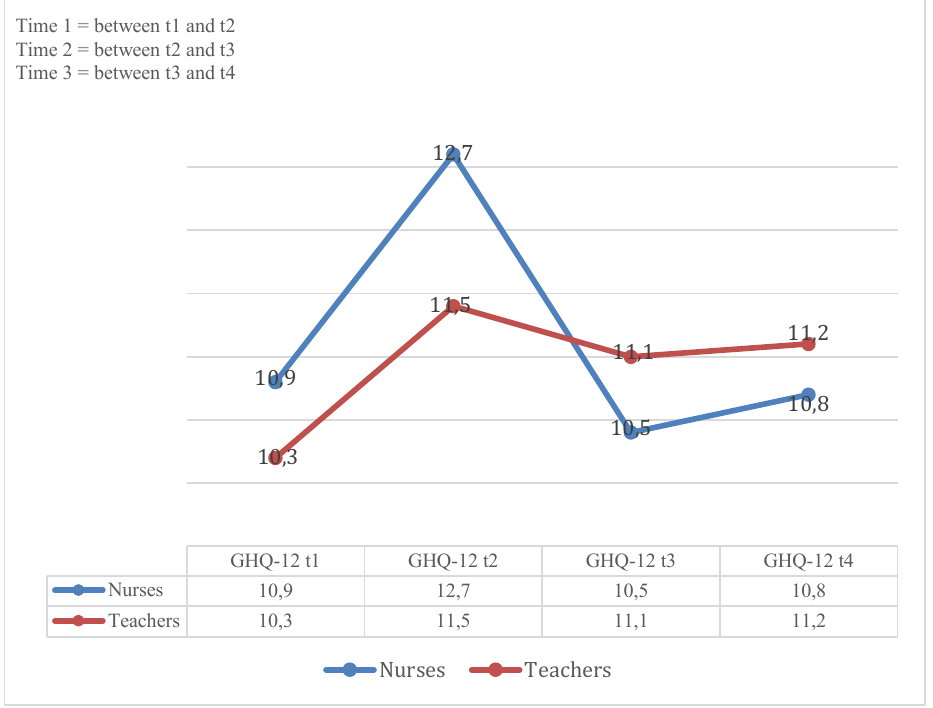
Figure 1. The model predicted estimated GHQ mean scores on all respondents on four measurements (t1, t2, t3 and t4)